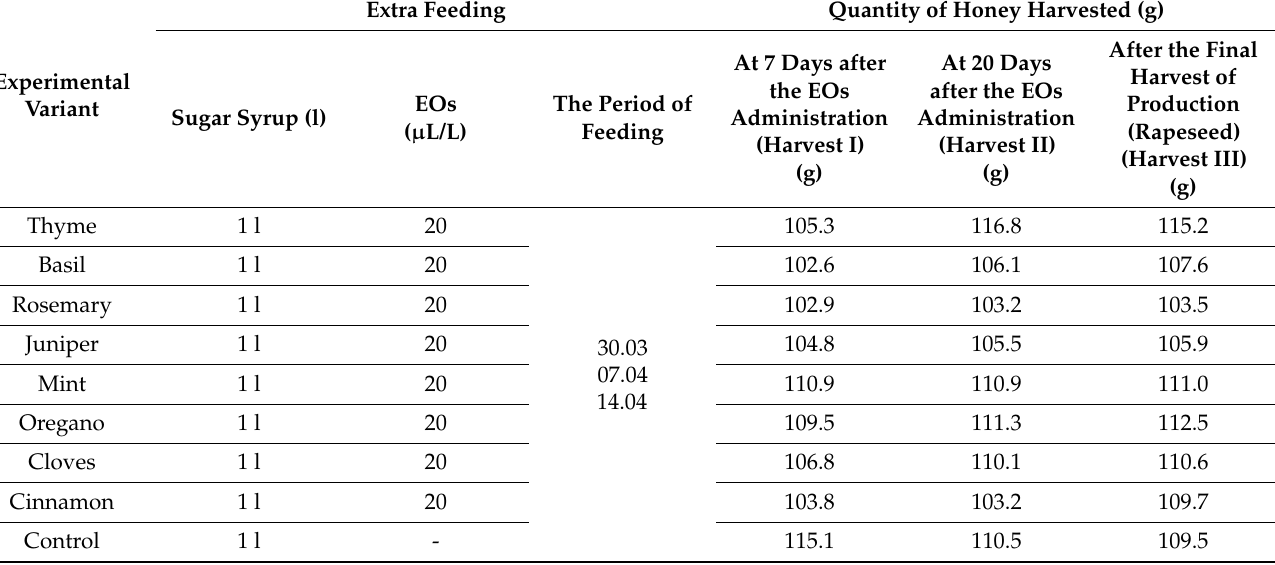
Table 2. Experiment organization